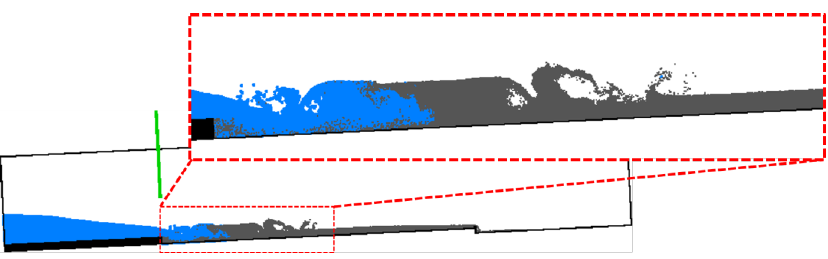
Figure 10. Schematic numerical model of the swash uprush problem.